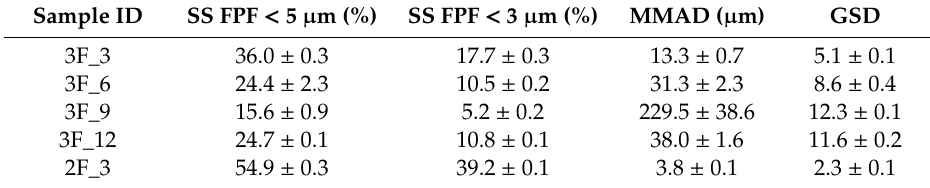
FPF: Fine particle fraction; MMAD: Median mass aerodynamic diameter; GSD: Geometric standard deviation.